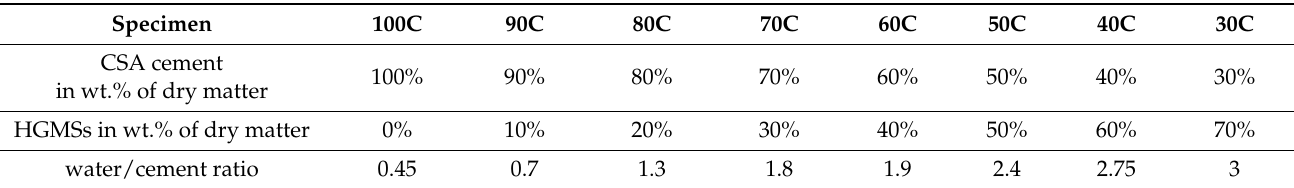
Table 2. Composition of the dry mixtures and the used w/c ratios.